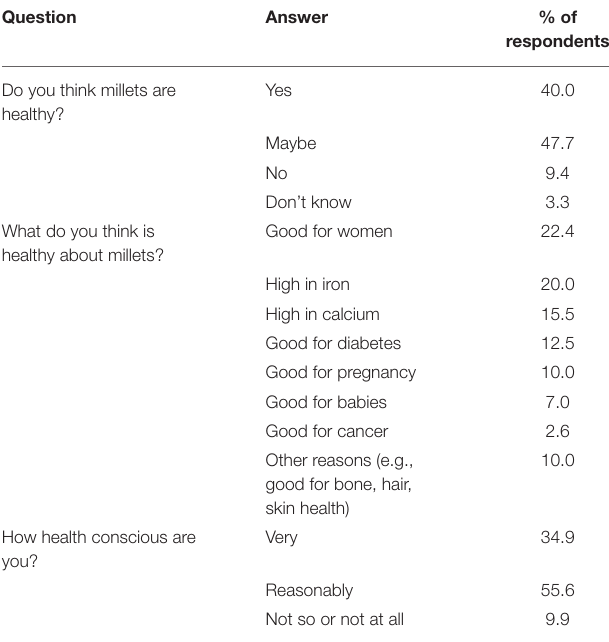
TABLE 3 | Health consciousness of the